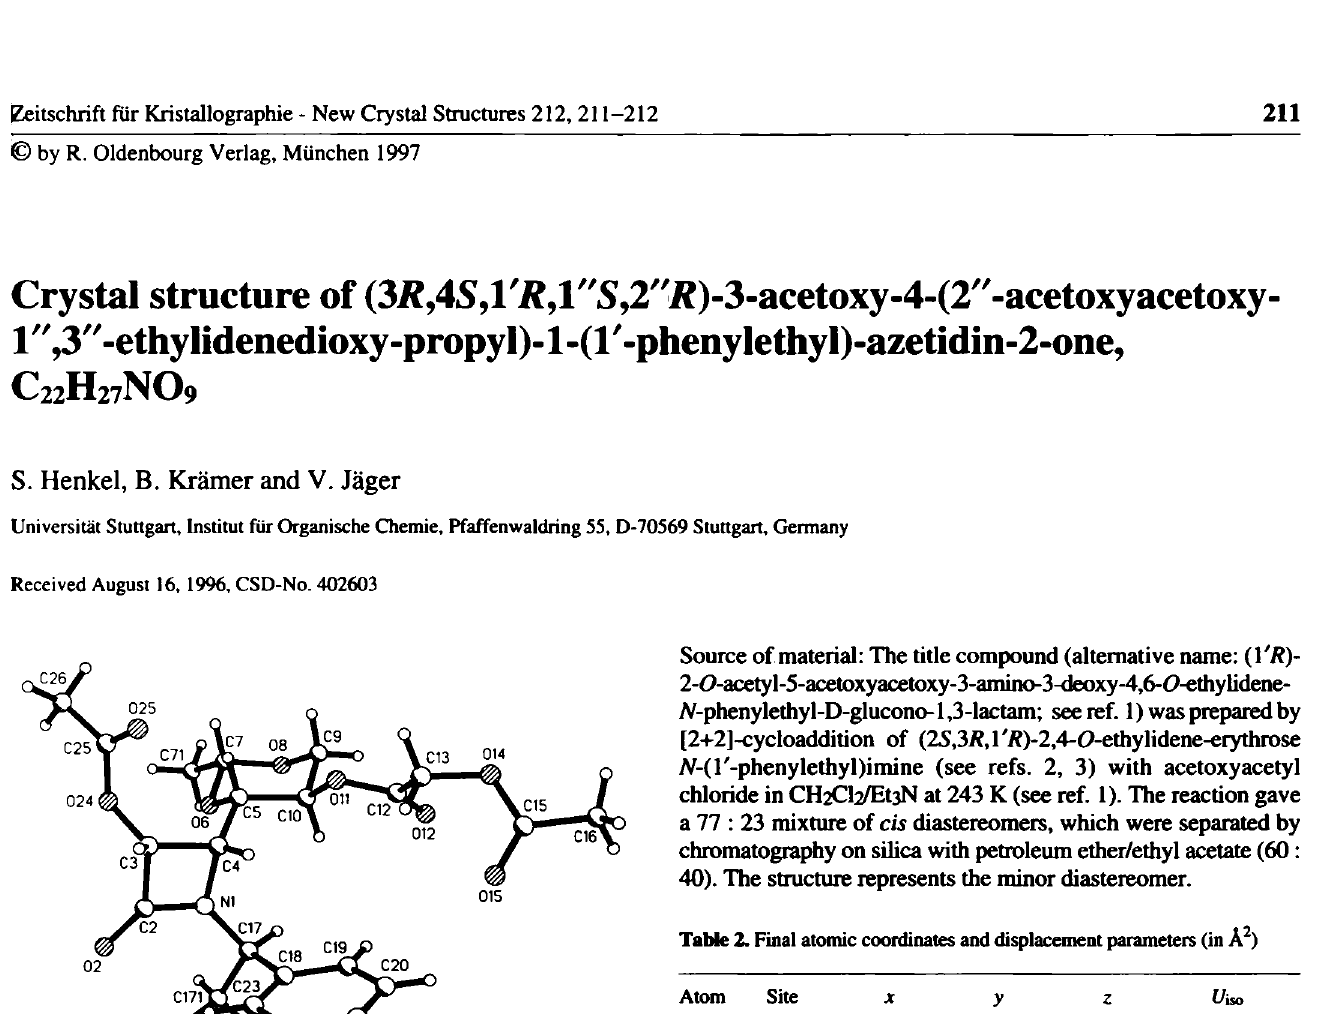
Table 2. Final atomic coordinates and displacement parameters (in Â 2 )